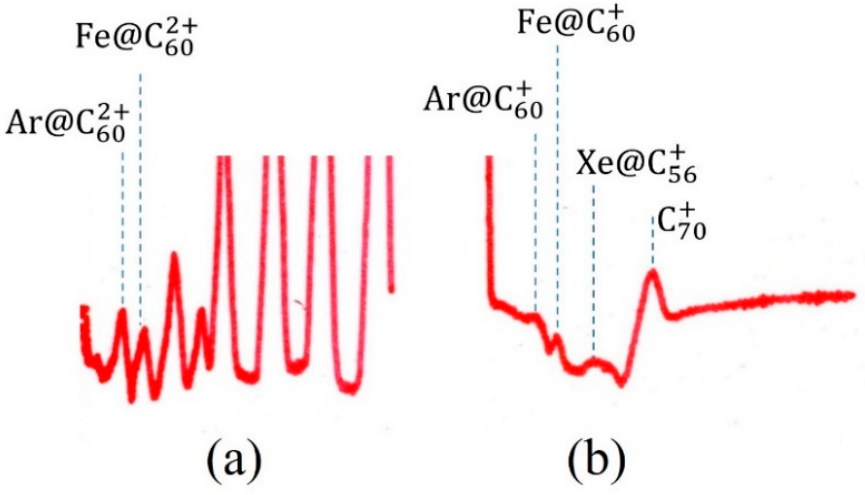
Figure 5. Detail spectrum on the high mass side of the C 60+ and C 602+ spectra (linear amplifier).